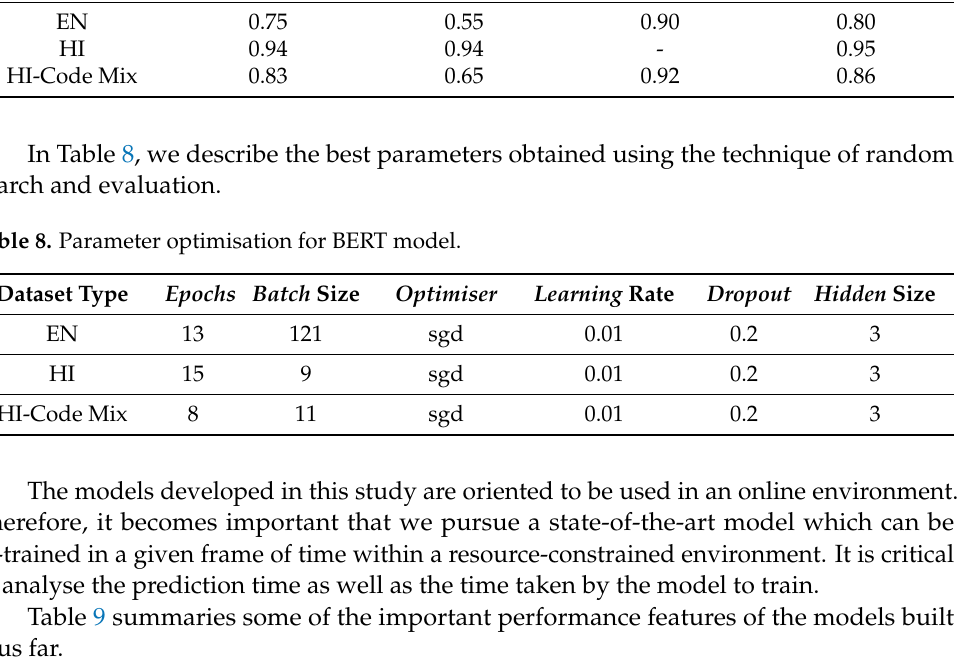
Table 7. Performance comparison of F1 scores and accuracy between classes for BERT model. Dataset Type